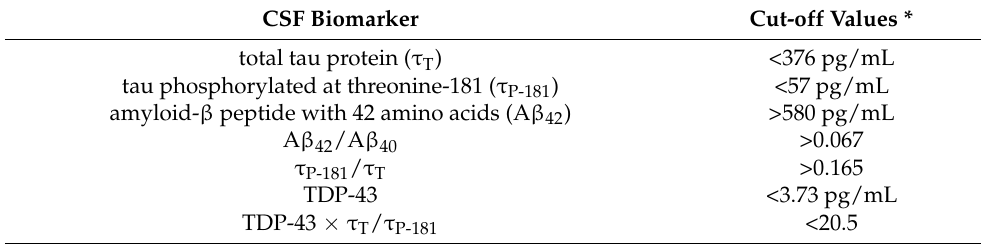
Table 1. Cut-off values of CSF biomarkers applied at our laboratory [18,23].